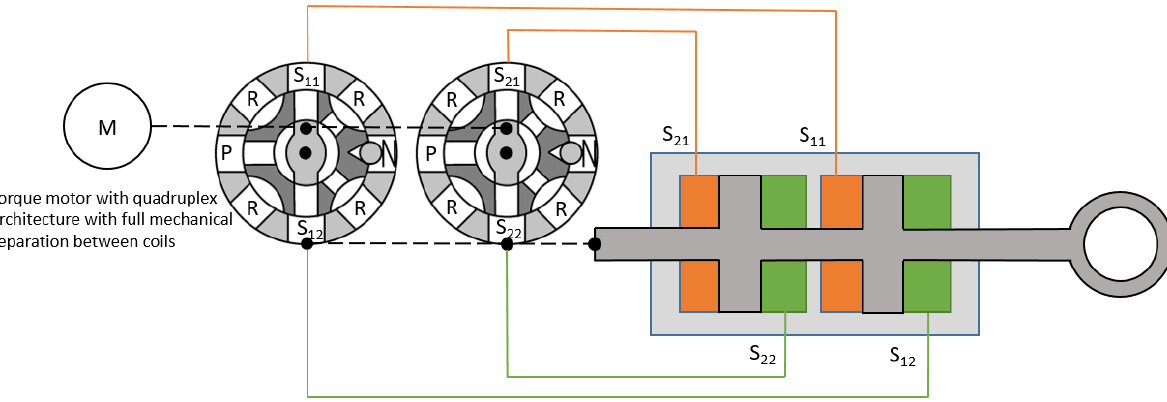
Figure 9. General schematic drawing of the FCA; own drawing based on patent [40] and Domin company materials [41].